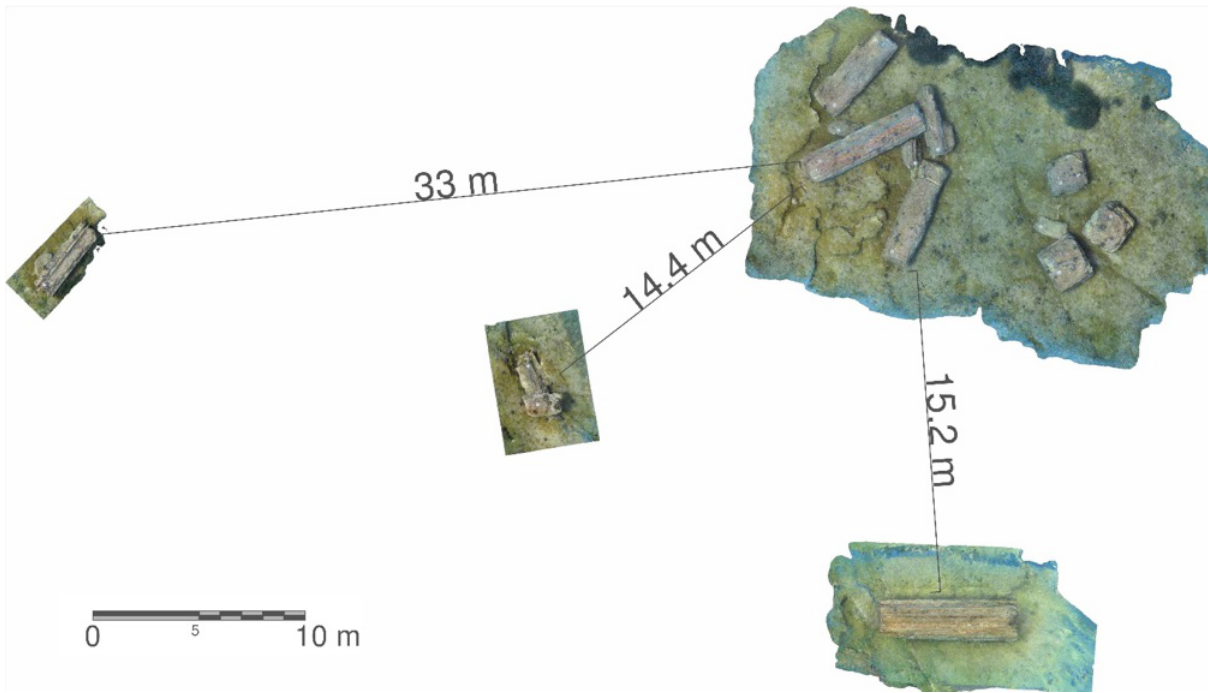
Figure 9. Orthophoto of Marzamemi shipwreck. Elaboration with Photoscan.